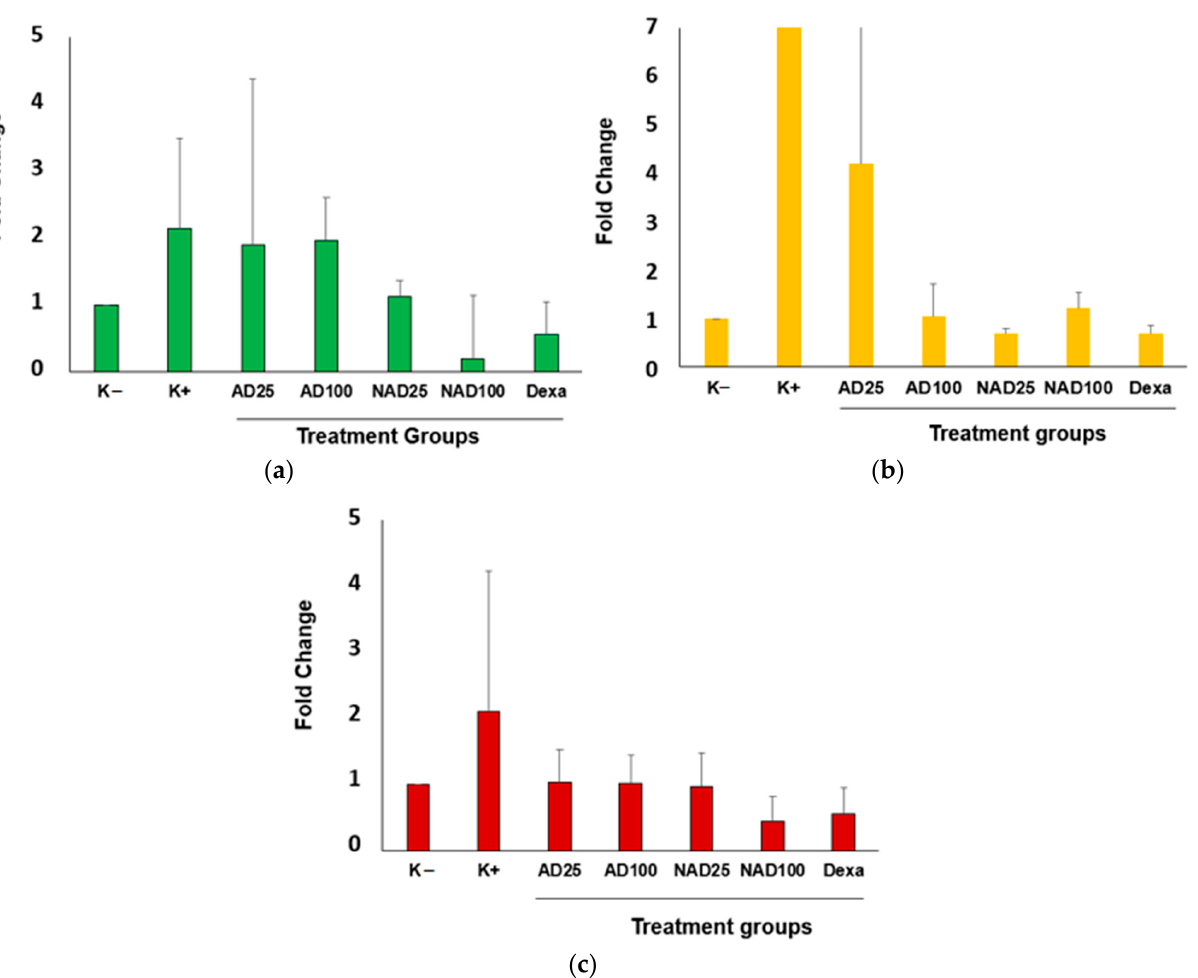
Figure 1. Effect of andaliman extract and nanoandaliman on gene expression of cox-2 ( a ), il-1b ( b ), and mmp1 ( c ) from cartilage tissue in CFA-induced mice. Samples were andaliman extract (25 and 100 mg/kg bw; AD25, AD100) and nanoandaliman (25 and 100 mg/kg bw; NAD25, NAD100). Dexamethasone (15 mg/kg bw; Dexa) was used as a reference anti-inflammatory drug. K − , untreated mice; K+, mice treated with CFA. P:0.233 (for cox-2 ); p:0.129 (for il-1b and mmp1 ) was determined by Kruskal–Wallis and continued by step-wise step-down post hoc test. There is no difference between Fc value and treatment groups. All experiments were performed in triplicate.